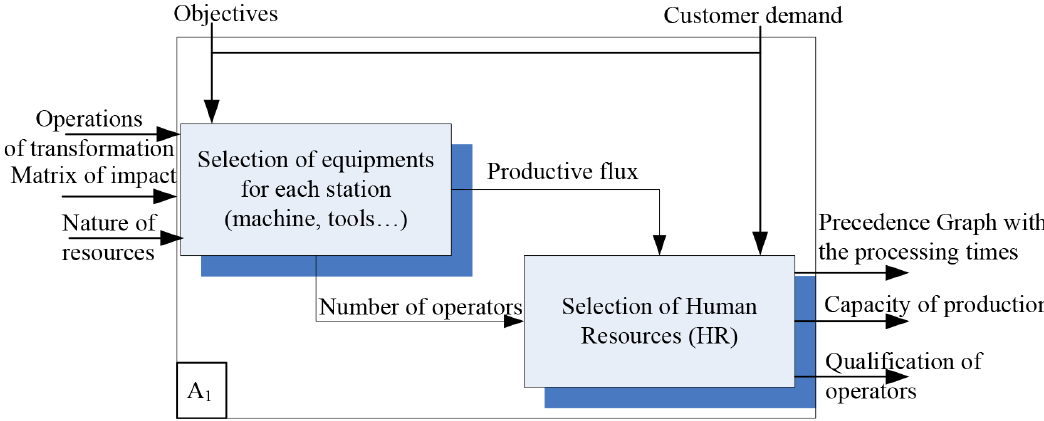
Figure 6. Activity A